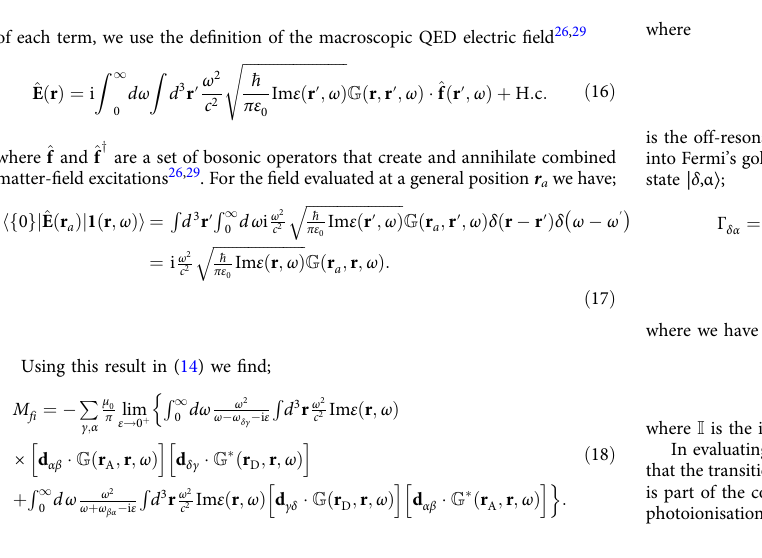
Fig. 6 Feynman diagrams for the ICD process. Diagrammatic illustration of the two processes ( a ) and ( b ) supported by our interaction Hamiltonian, for donor D and acceptor